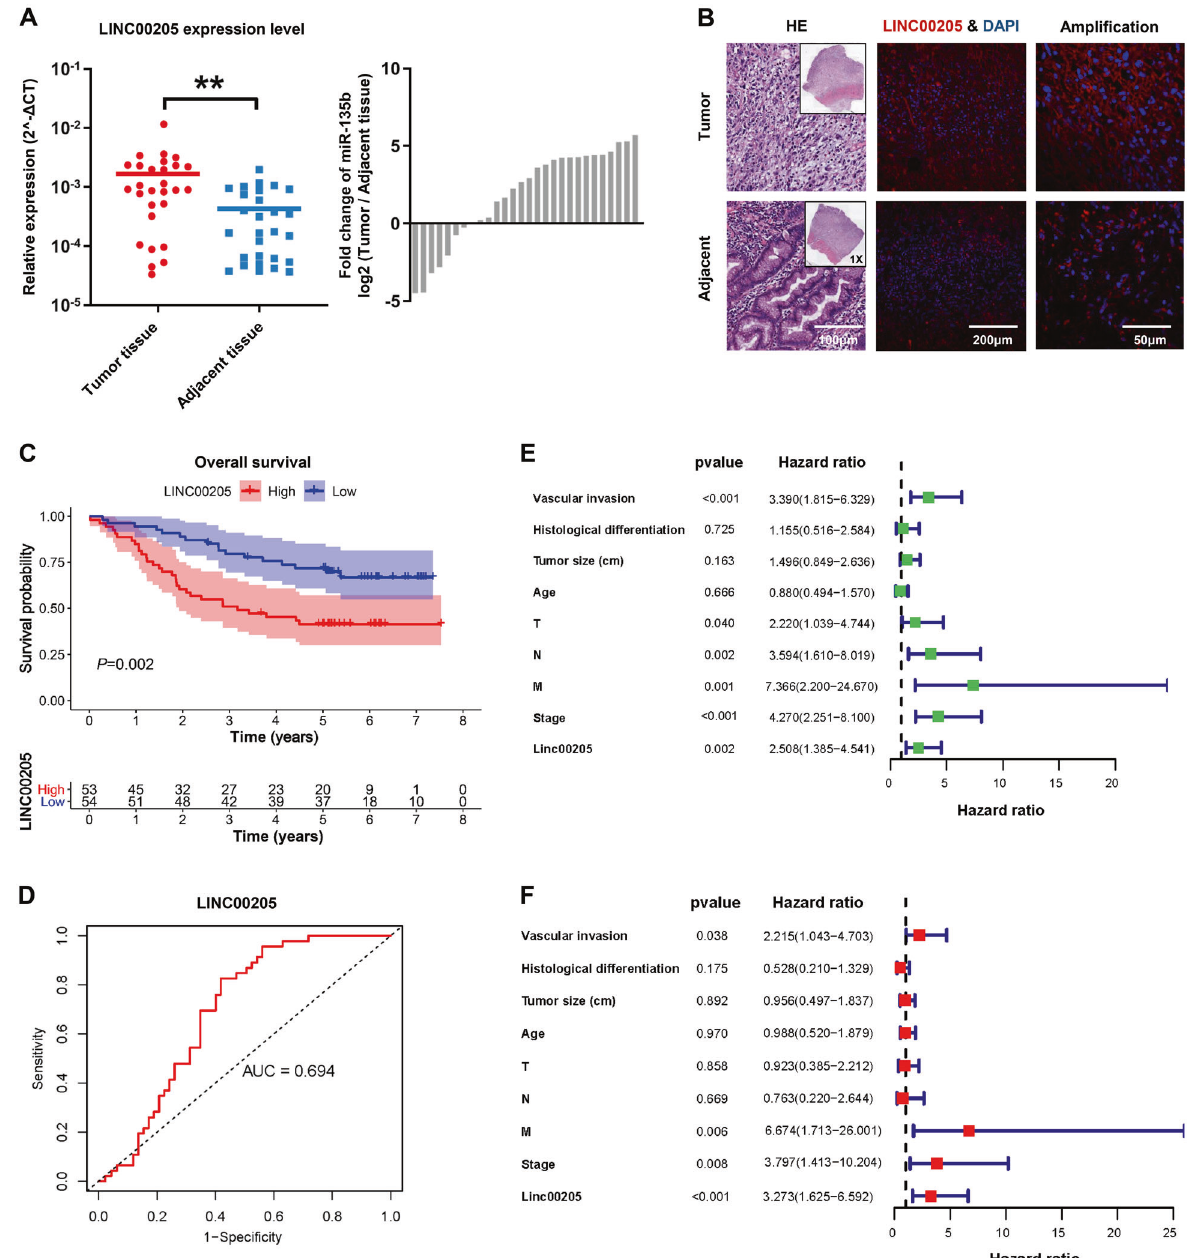
Fig. 1 LINC00205 overexpression was strongly associated with gastric cancer (GC) pathogenesis. A The expression of LINC00205 in GC tissues and matched adjacent normal tissues from 28 patients in the Peking University Cancer Hospital (PUCH) cohort. ** P < 0.01 calculated by paired Student ’ s t -test. B RNA FISH of GC tissues and adjacent tissues showing LINC00205 expression. Hematoxylin and eosin (H&E)-stained section is shown (left). Tissues imaged under fl uorescence illustrating LINC00205 expression in a subpopulation of cells; high magni fi cation is shown (right). LINC00205 probe (red) and DAPI (blue). Scale bar, 100 μ m. C Kaplan – Meier plots for the overall survival rate of patients with GC in group of LINC00205 high or low expression levels in the PUCH cohort. P = 0.002 calculated by the log-rank test. D The time-dependent ROC curves for 5 years overall survival were used to assess the prognostic accuracy of LINC00205 expression level. Data were bootstrap-corrected AUC. E The univariate analysis and F The multivariate analysis of prognostic parameters in patients with GC by Cox regression